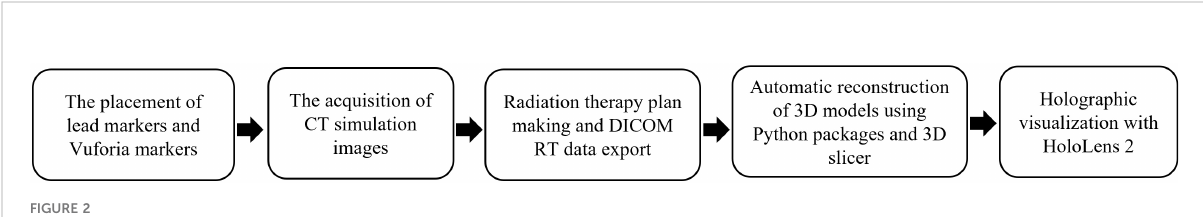
FIGURE 2 The fl ow from CT simulation image acquisition to holographic model visualization.